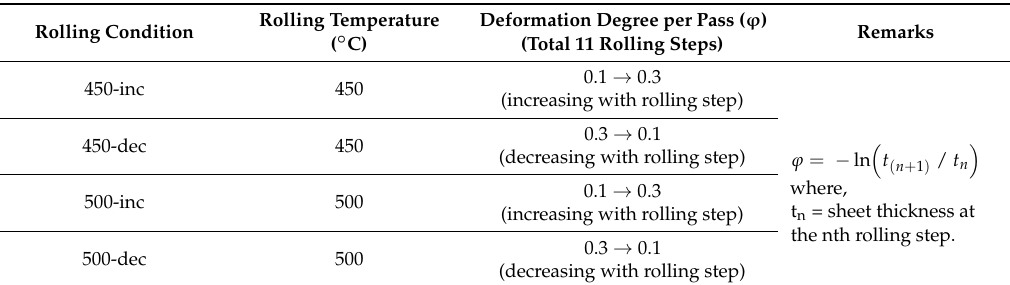
Table 1. Different rolling conditions used in the present